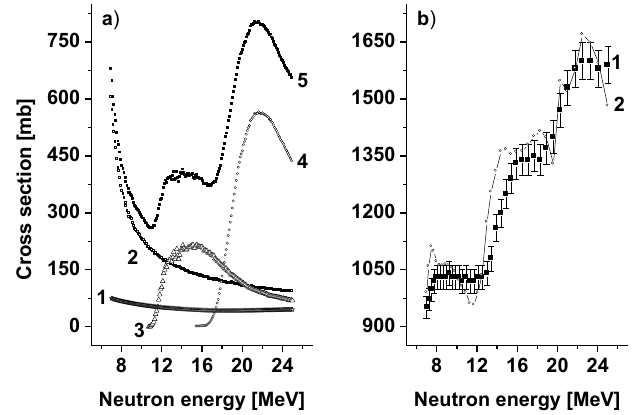
Fig. 1. Total cross section (TXS). a) TXS and contribution of fissile nuclei: 1- 239 U; 2- 238 U; 3- 237 U; 4- 236 U; 5- 1+2+3+4. b) Comparison between: 1) Experiment [13]; 2) Talys